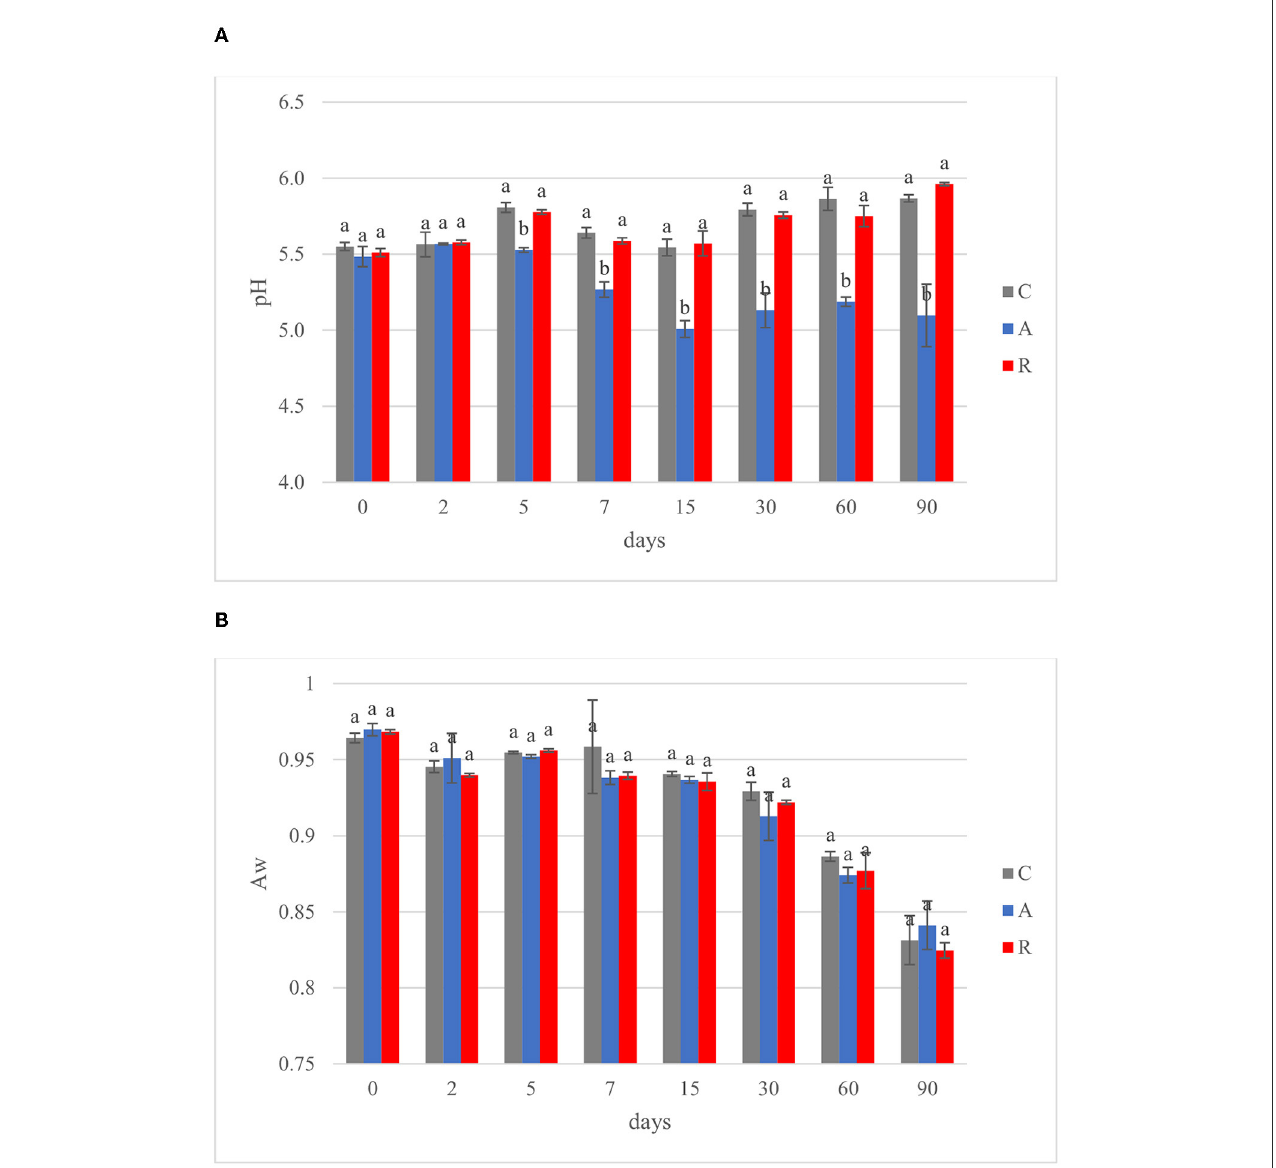
FIGURE3 Evolution of (A) pH and (B) water activity (Aw) during ripening of: non-inoculated sausages, C; sausages inoculated with Lcb. casei N87 cultivated under anaerobiosis, A; sausages inoculated with Lcb. casei N87 cultivated under respiratory conditions, R. Error bars refer to the standard deviations obtained from triplicate sample analysis. Different letters (a, b) indicate significant differences among different batches at the same fermentation time ( p < 0.05).